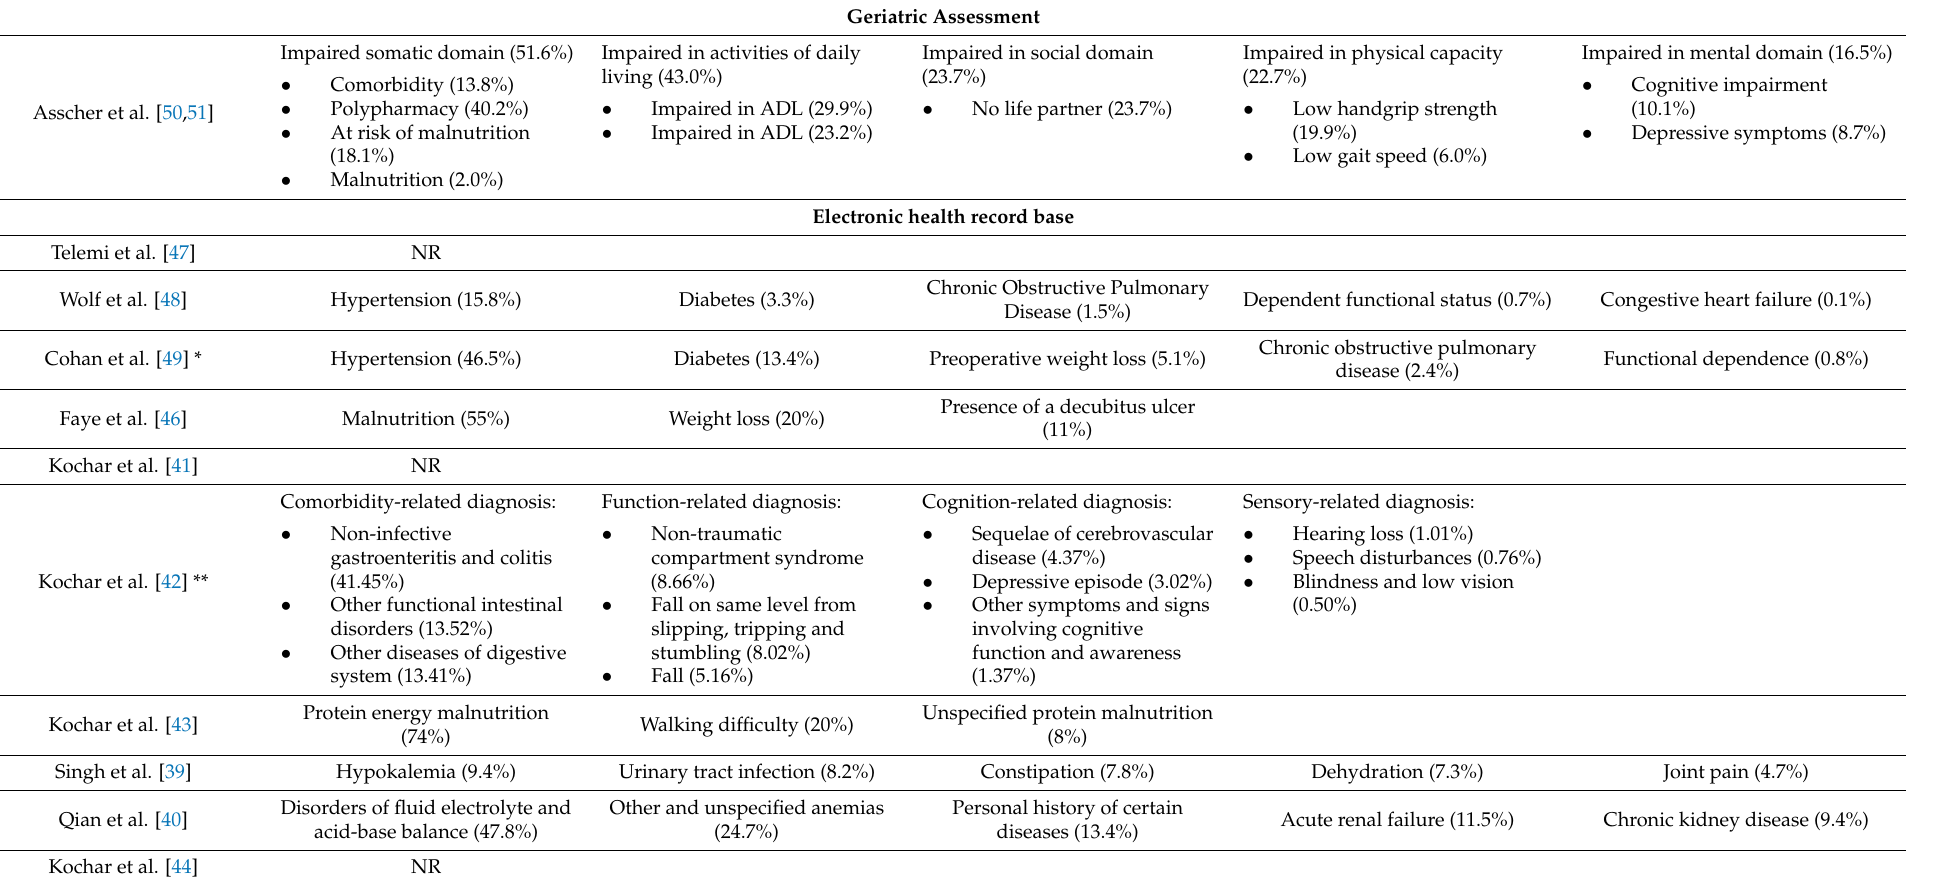
Table 3. Prevalence and type of frailty defining diagnosis per